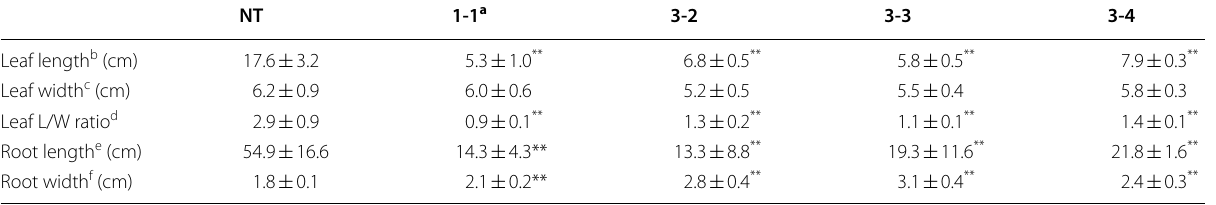
Three plants each from the NT line and four GA2ox6-OX transgenic lines (#1-1, #3-2, #3-3 and #3-4) were measured and compared a Plants of line #1-1 were grown in 9 cm pots at a relative early stage (Additional file 1: Fig S5). Others were grown in 10.5 cm pots b Leaf length average SE of the longest leaf from 3 individual plants ± c Leaf width average SE of the same longest leaf from the above 3 individual plants ± d Ratio of leaf length to leaf width e Root length average SE of the longest root from 3 individual plants ± f Root width average SE of the thickest root from 3 individual plants ± ** Average SE (n 3) showed a significant difference from the NT control with a p-value < 0.01 ± =